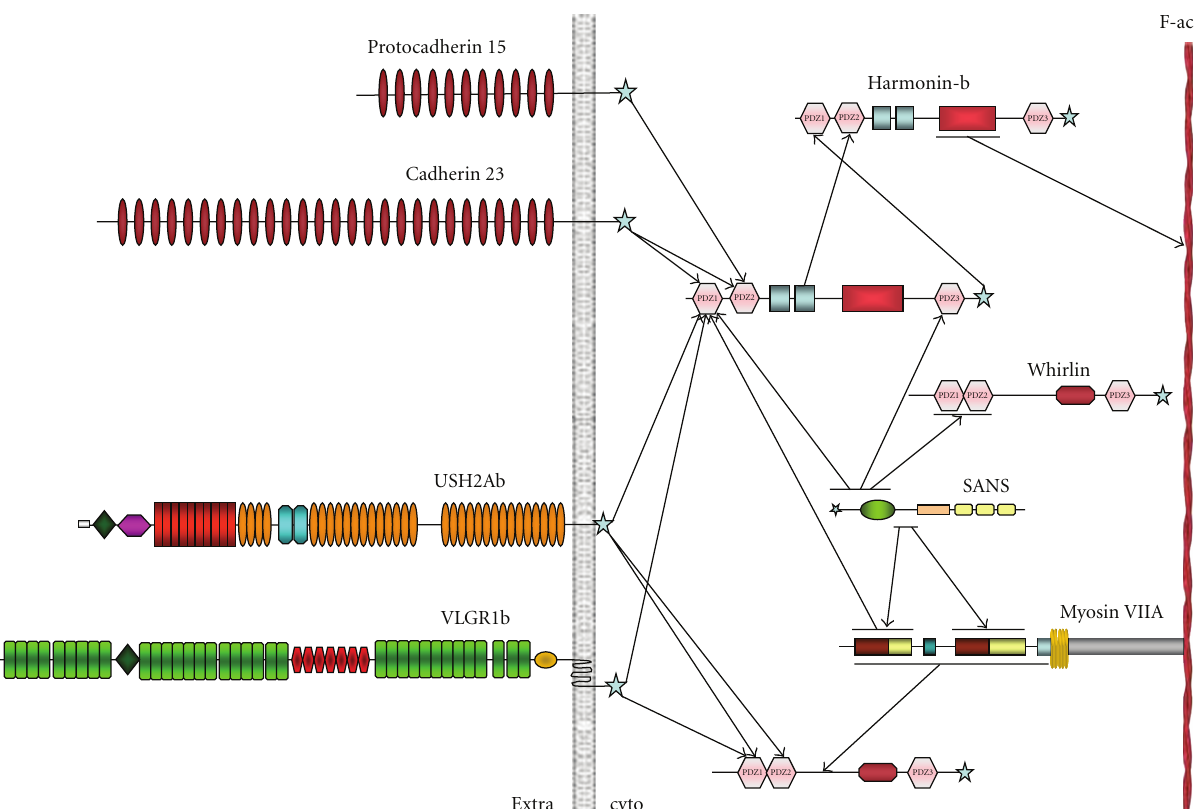
Figure 1: Schematic diagram illustrating the deciphered interactions within the USH protein network interactome adapted from van Wijk et al.